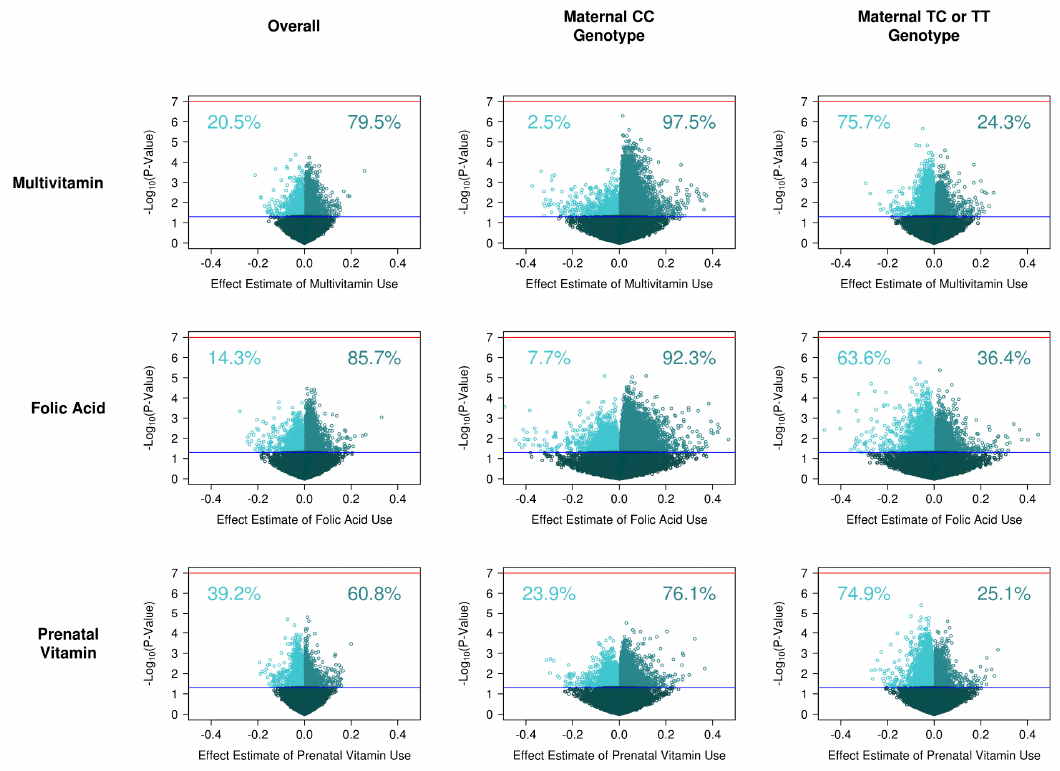
Figure 1. Association between maternal supplement use in the 3 months prior to conception and cord blood DNA methylation. Each dot represents a CpG site measured on the array. Percentages of nominal ( p < 0.05) CpGs that are hypo / hyper methylated are shown.